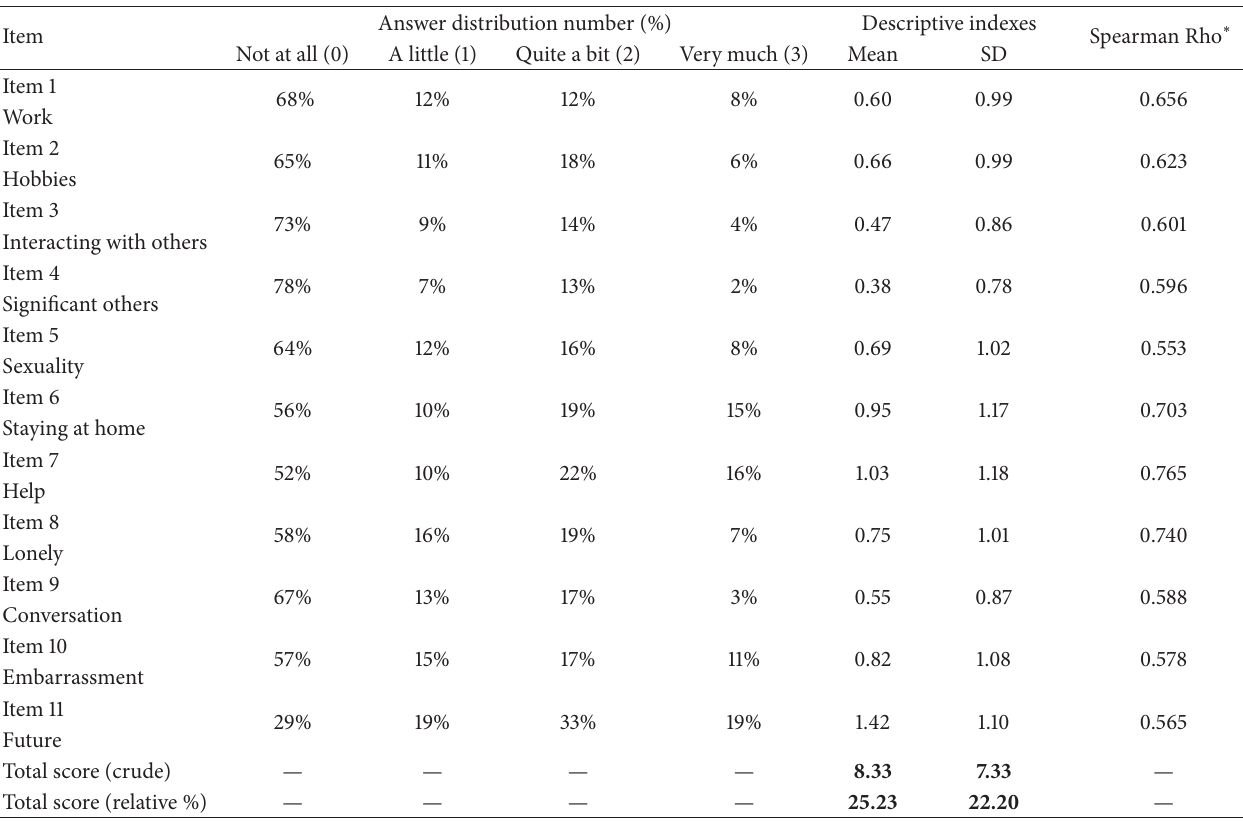
∗ All correlation coefficients are statistically significant with 𝑃 < 0.001 .